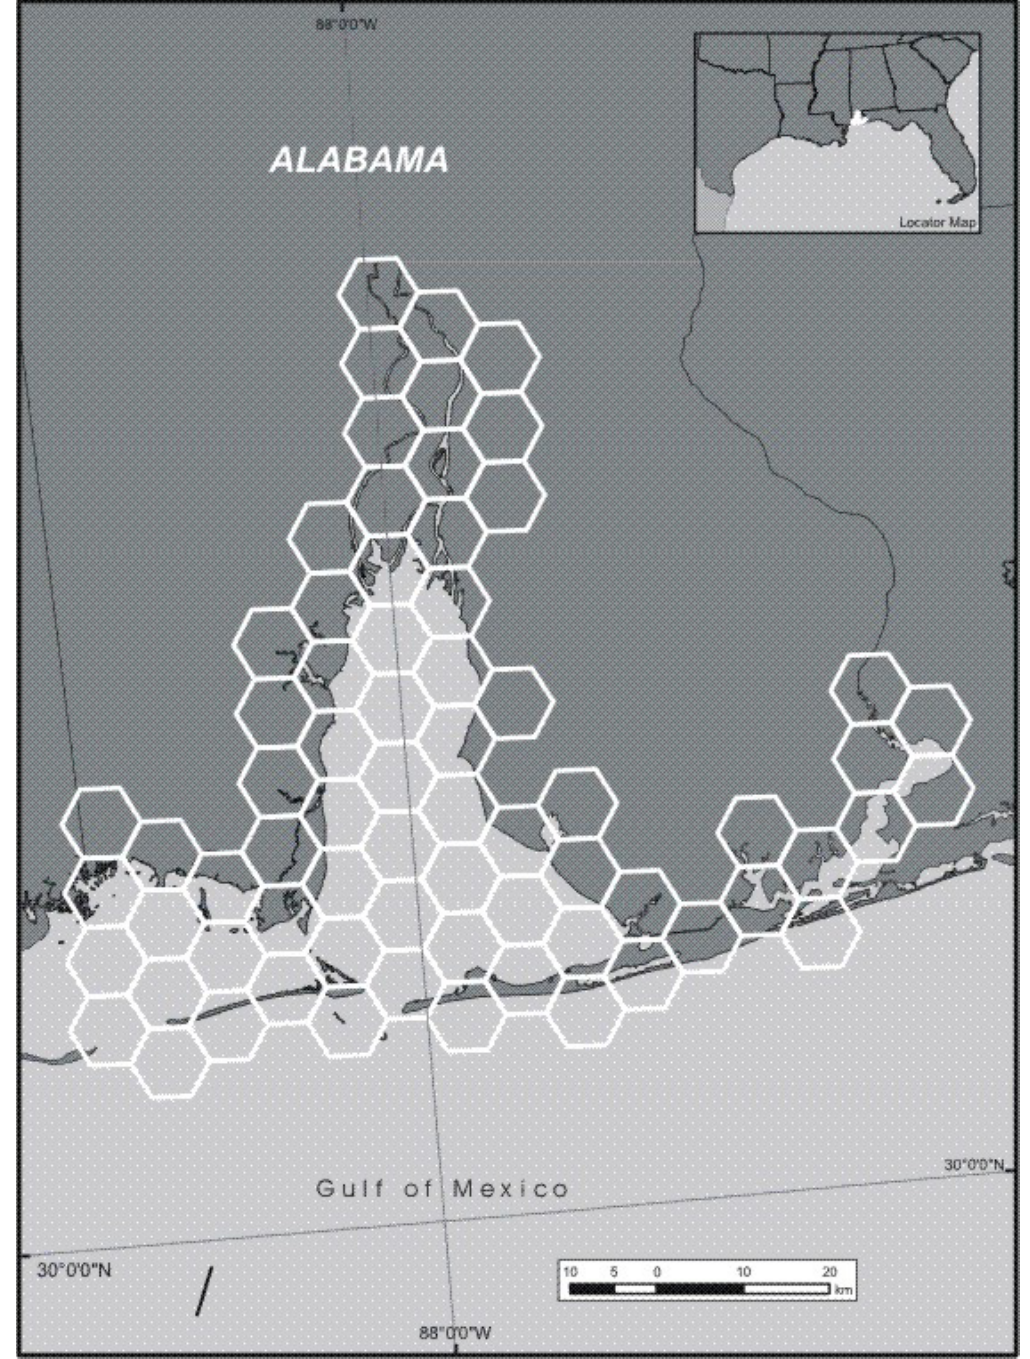
Fig. 1. Mobile Bay and adjacent Alabama estuaries overlain with a hexagonal grid for estimation of blue crab recruitment from selected habitat